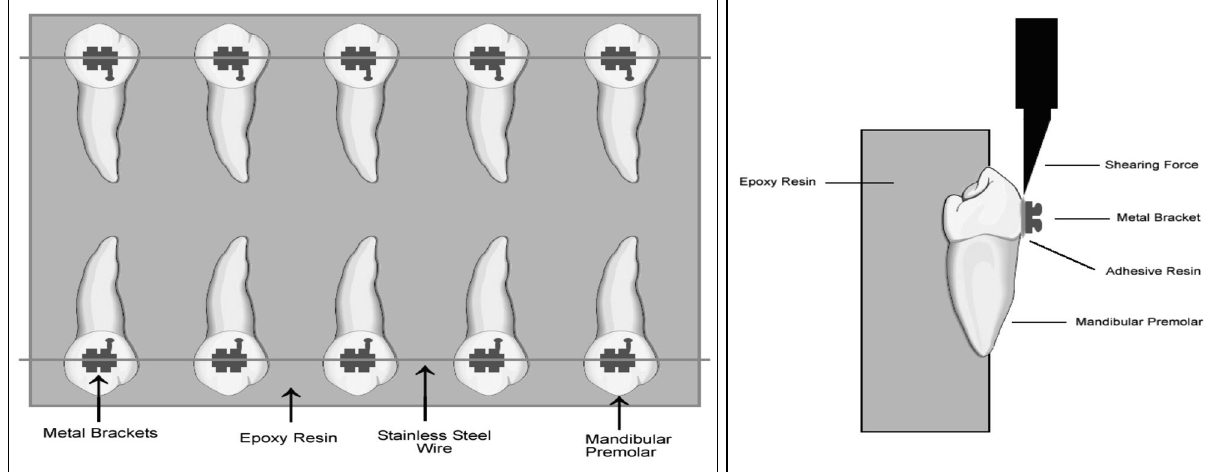
Figure 1. Samples set in epoxy resin. Figure 2. Mounting of sample.